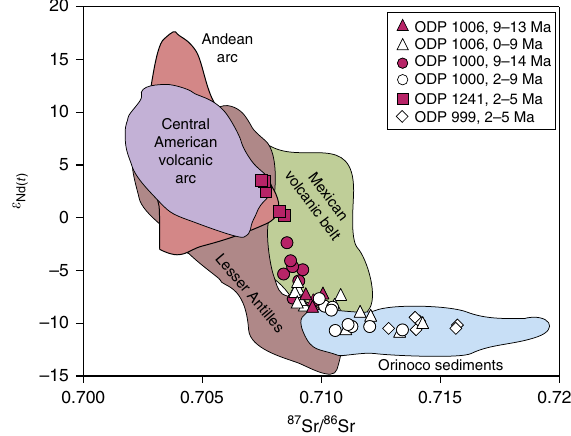
Fig. 3 Detrital fraction Nd and Sr isotope compositions. Comparison of Nd Program Sites 1006, 1000, 999 and eastern equatorial Paci fi c Site